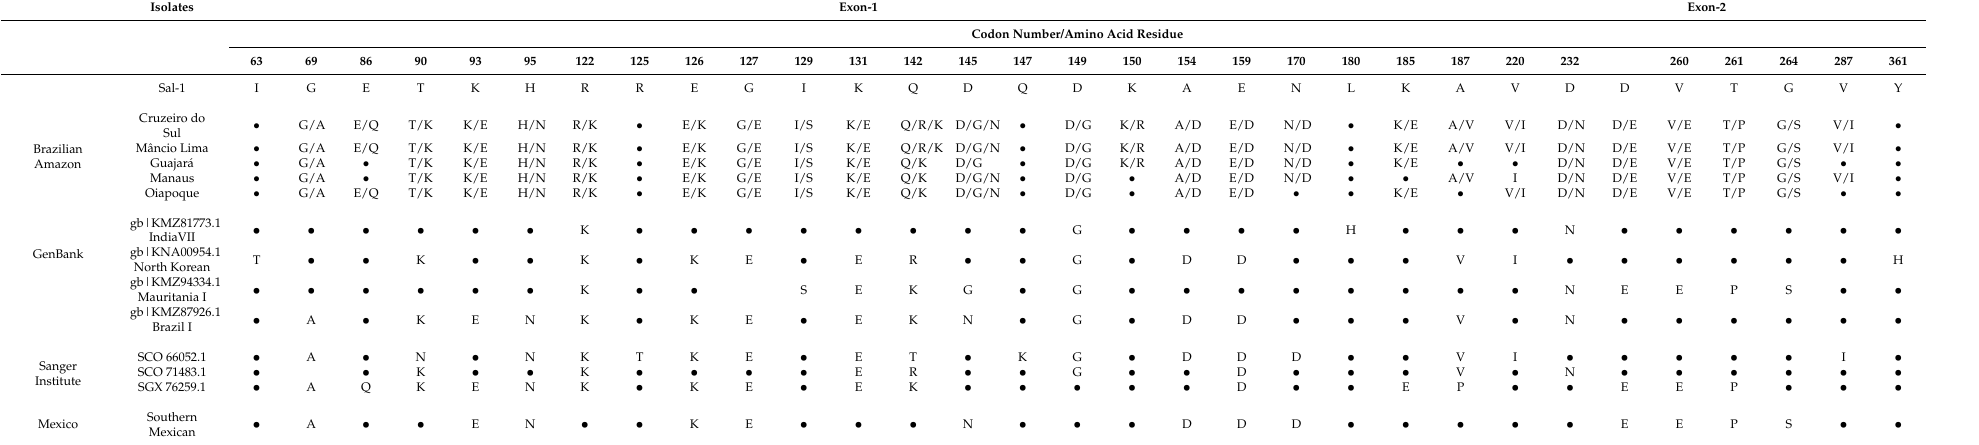
Table 4. Comparison of amino acid variations of the PvCyRPA protein between the Brazilian Amazon and genome sequences available worldwide. Isolates